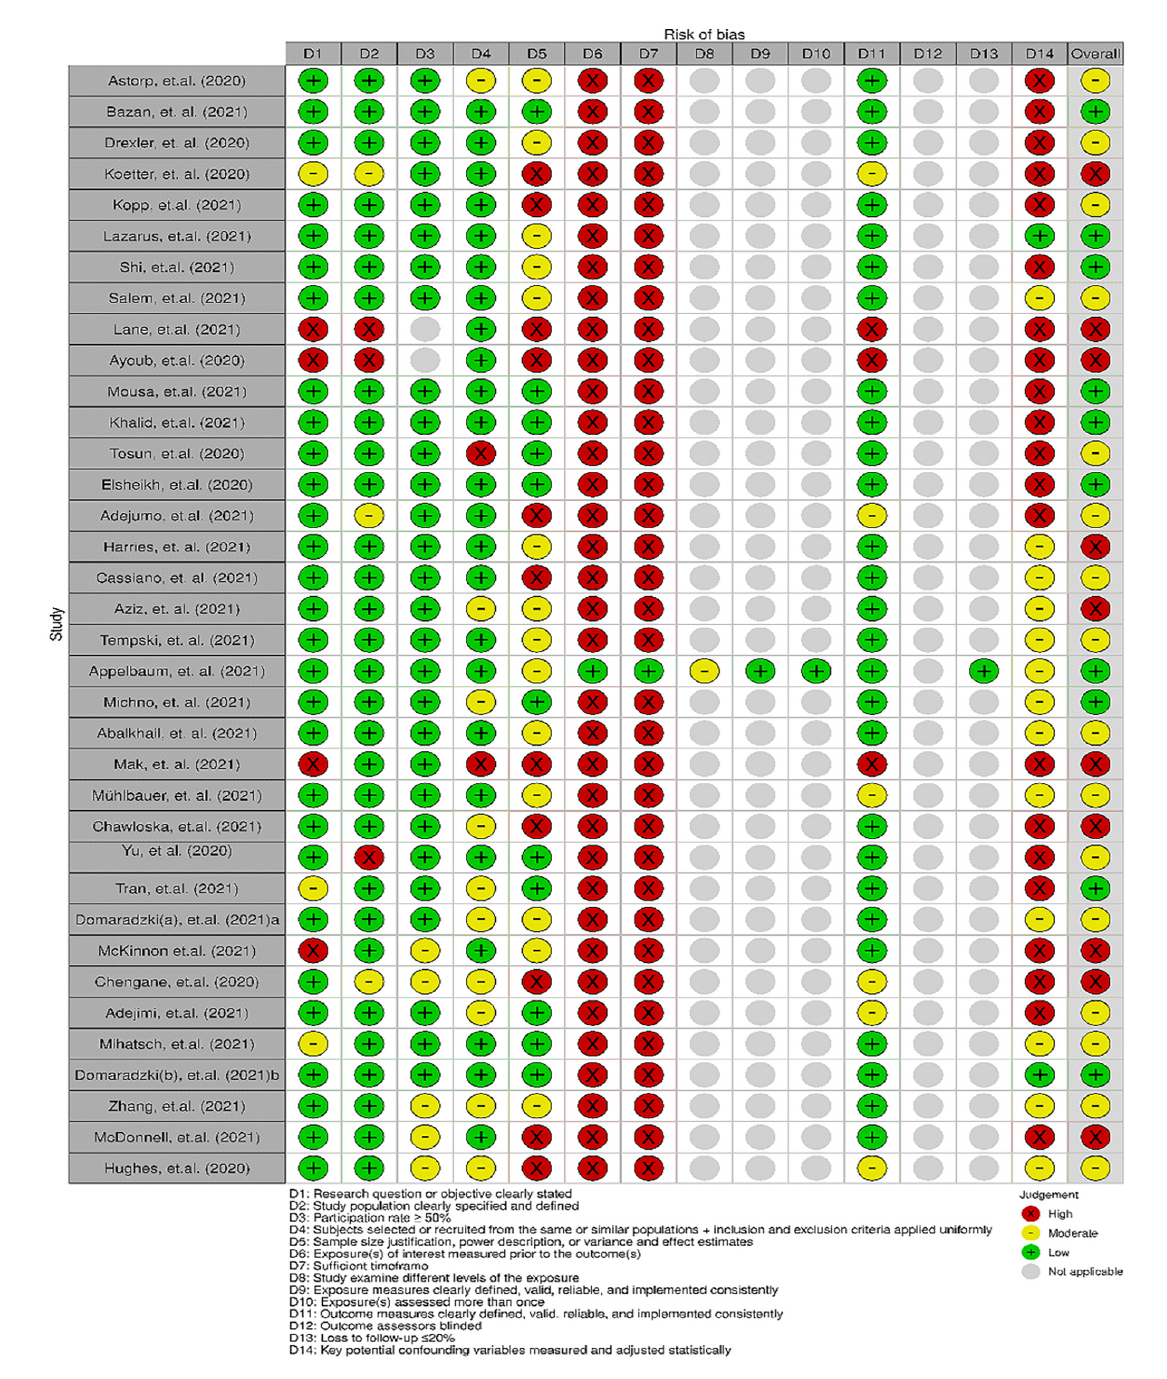
FIGURE2 Individual study risk-of-bias assessment using National Institutes of Health Quality Assessment Tool for Observational Cohort and Cross-Sectional Studies checklist.